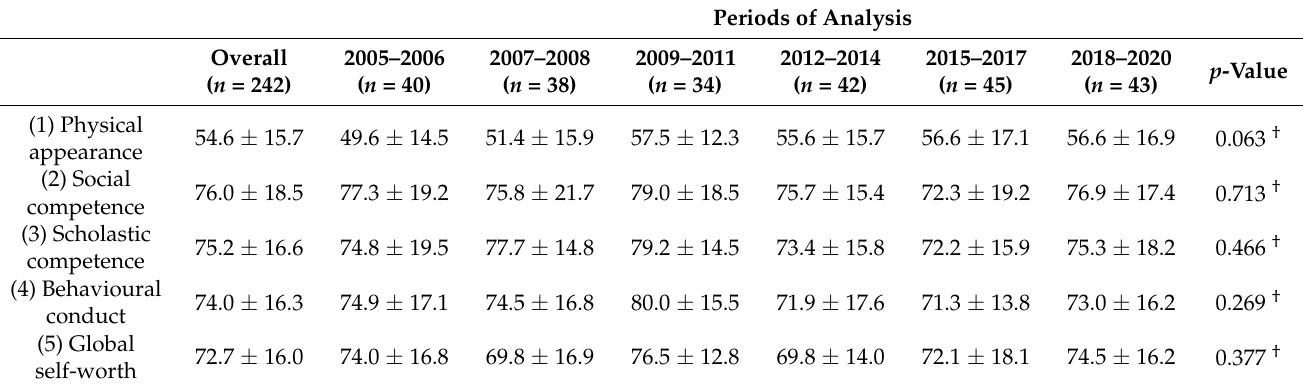
Table 3. Results analysing differences in the domains of self-concept over time.